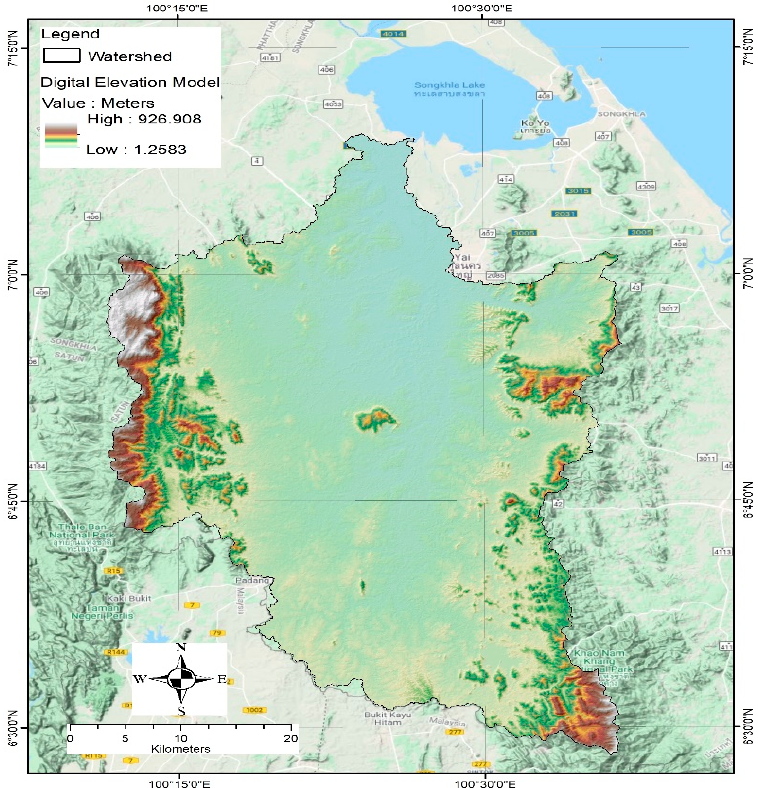
Figure 3. Digital elevation model (DEM) of the U-Tapao river basin .